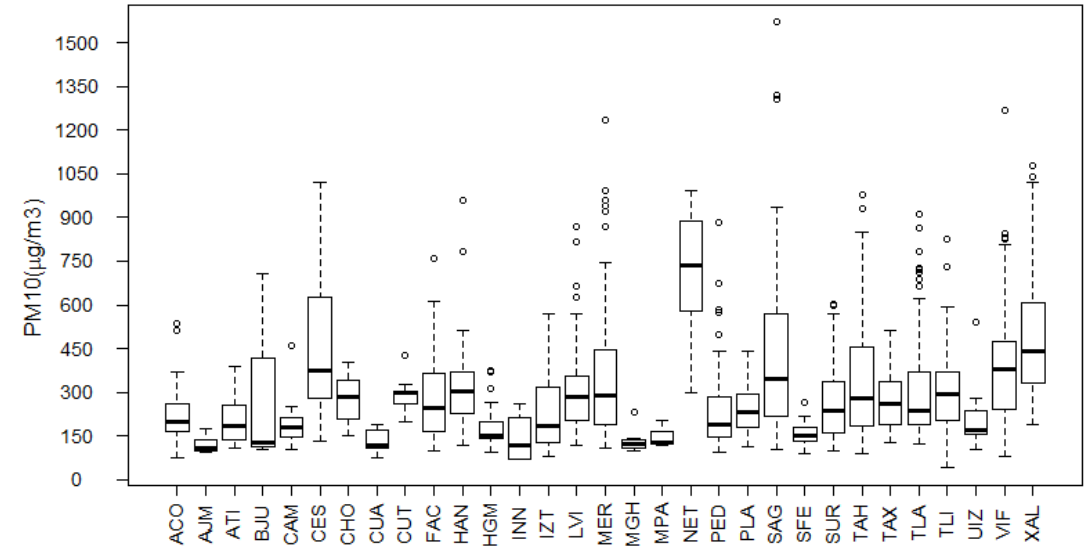
Figure 4. Boxplots of the PM 10 maxima at 31 monitoring stations in the Mexico City metropolitan